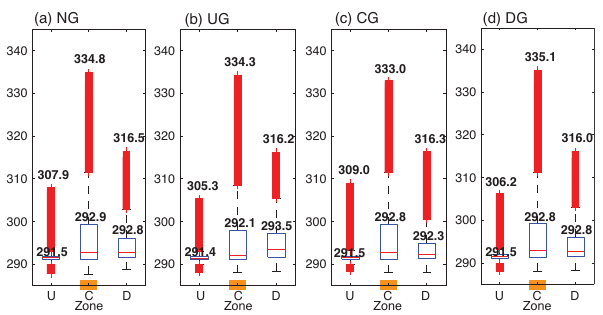
Figure 11. As in Fig. 8 but for temperature (K).